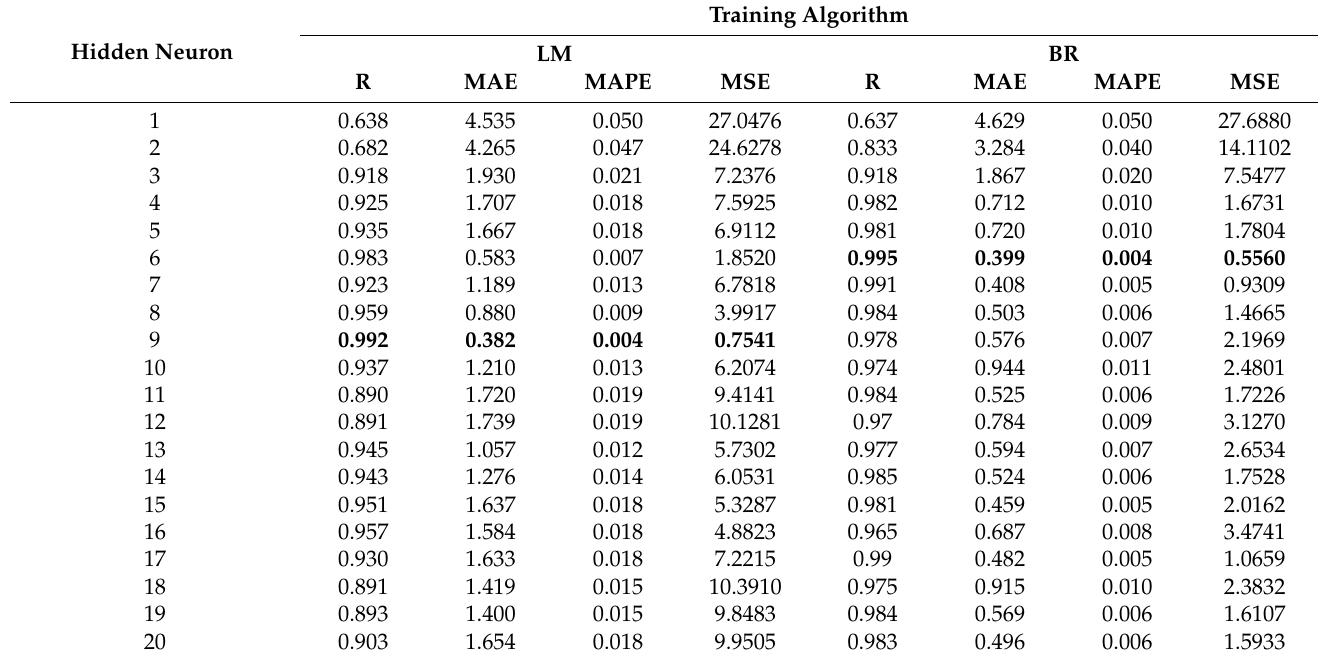
Table A21. R, MAE, MAPE, MSE value for TSS removal for different training algorithms at different number of hidden neurons (aerobic